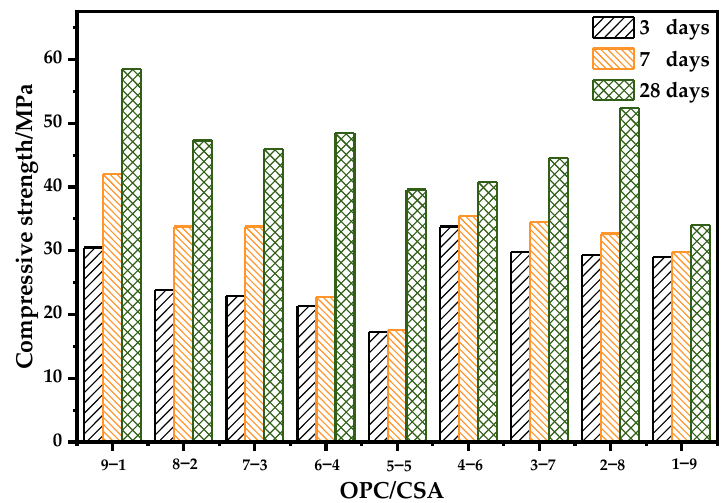
Figure 14. The compressive strength of OPC-CSA systems.